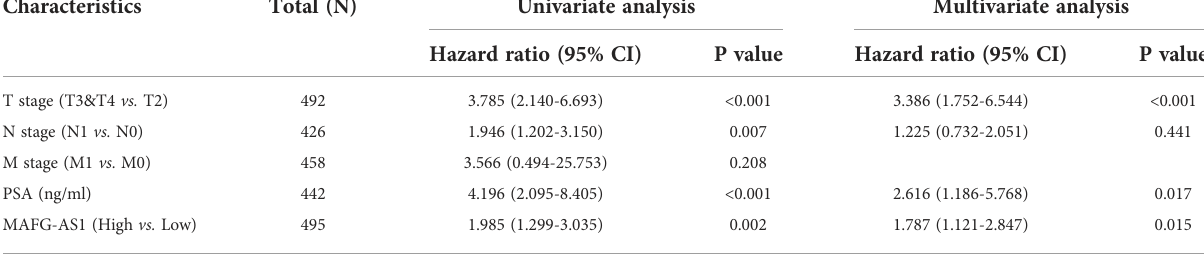
TABLE 3 Univariate and multivariate analysis of factors associated with PFI using Cox regression.